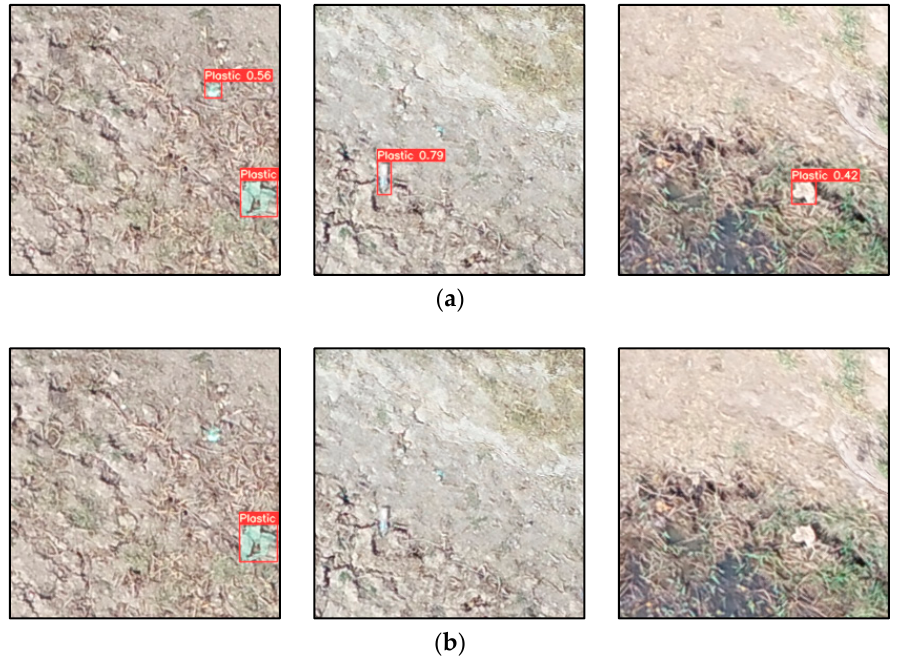
Figure 10. The TT model fine-tuned on HMH performs well in some cases. ( a ) HMH model result on HMH. ( b ) TT model results on HMH with fine-tuning.